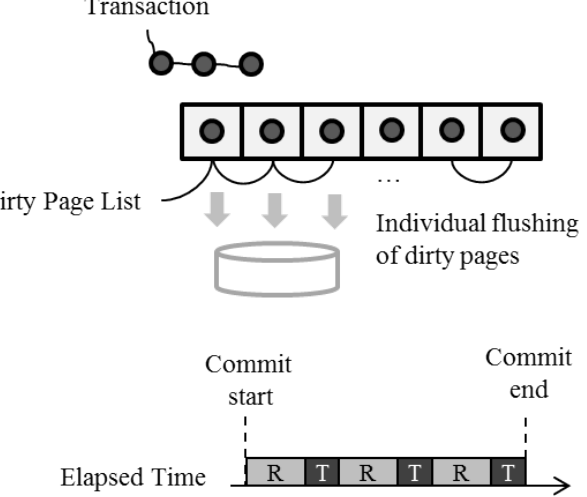
Figure 4. SQLite large transaction processing. The subfigure at the bottom shows the transaction commit timeline. The gray box with R denotes the memory reclamation time duration and the black box with T indicates the data writing time duration of the transaction into the